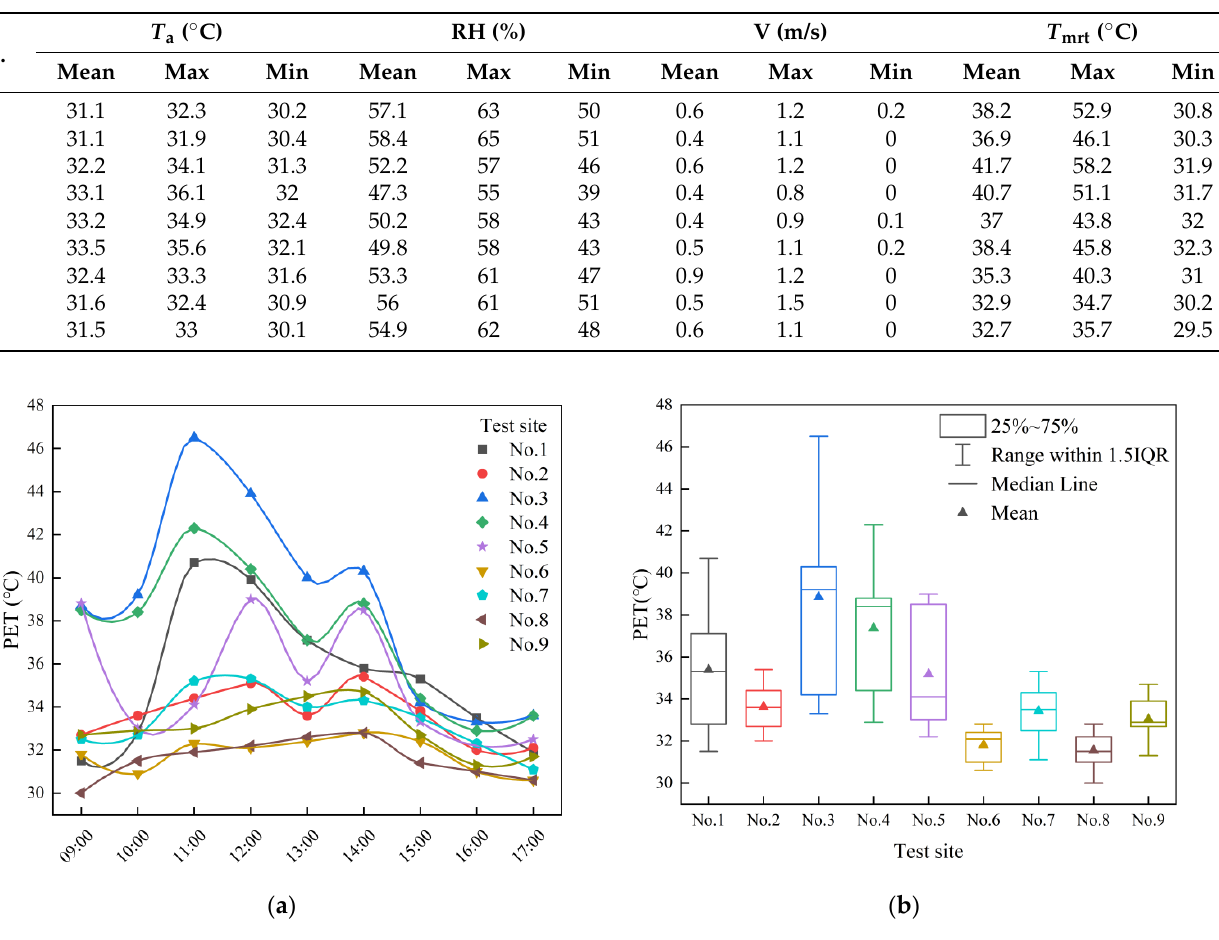
Table 5. The mean, minimum, and maximum of thermal environmental data at nine test sites. Figure 6. A comparison of neutral PET ranges in different areas. (Dwa: monsoon-influenced hot-